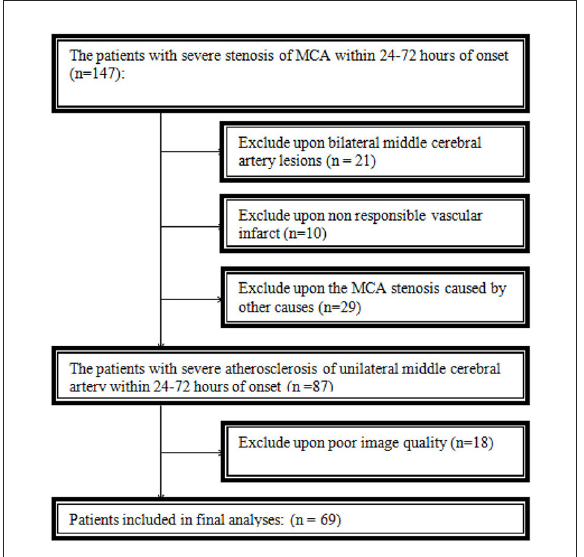
FIGURE2 Population flowchart. MCA, middle cerebral artery.